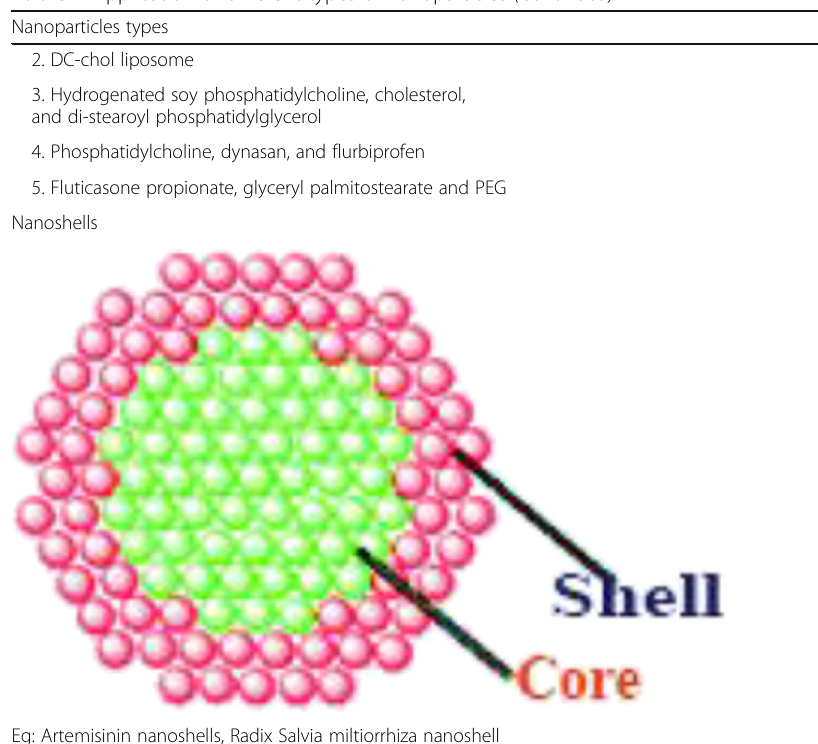
Table 2 Application of different types of nanoparticles